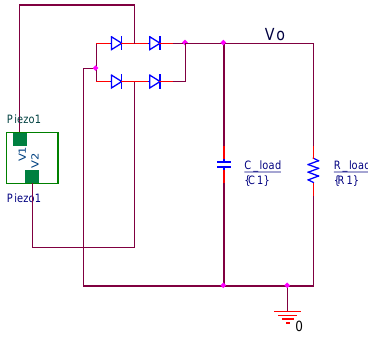
Figure 11. Harvesting circuit.